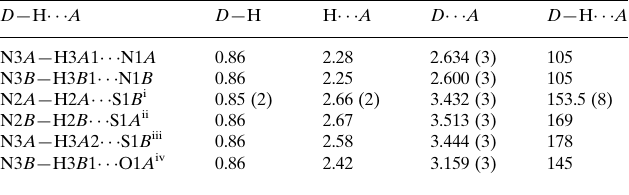
Hydrogen-bond geometry (A ˚ , (cid:2) ). D —H (cid:3)(cid:3)(cid:3)